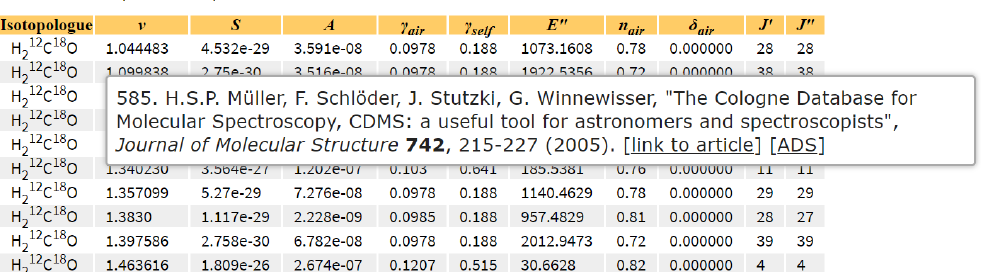
C 18 O of formaldehyde in the 2